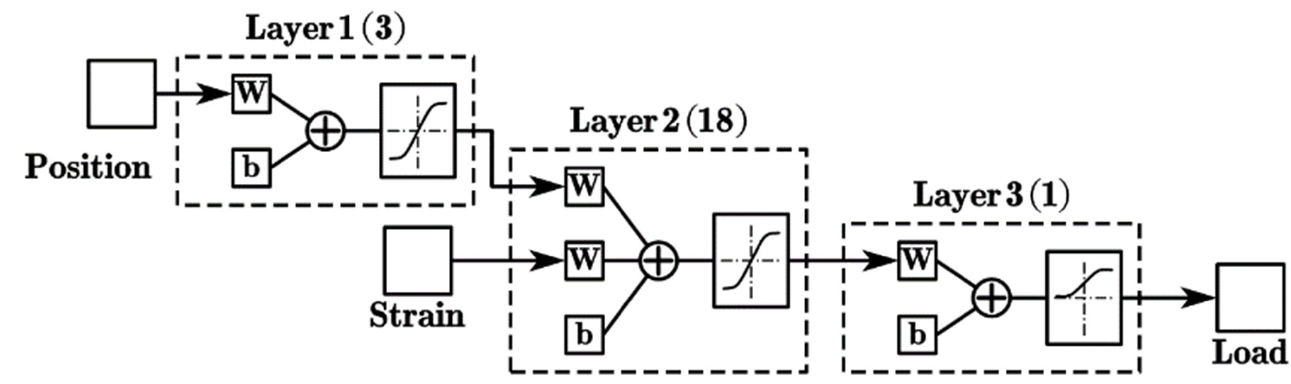
Figure 17. Neural network structure.